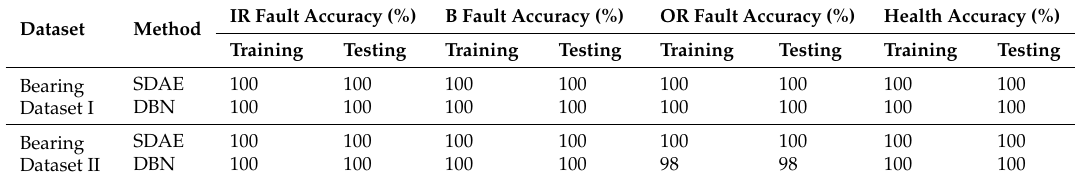
Table 2. Identification results of bearing fault obtained by SDAE and DBN.